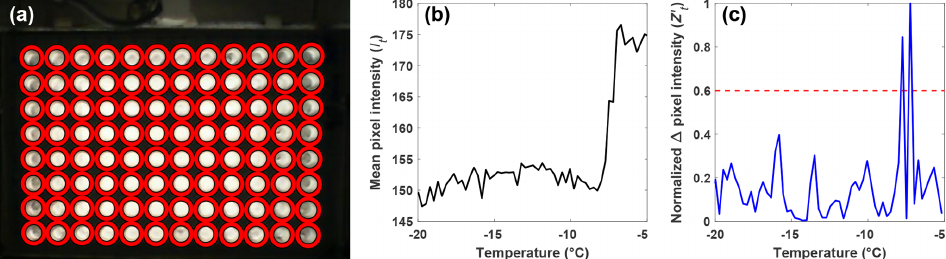
Figure 2. (a) Automatic detection of the wells (red circles) using a CHT. (b) Light intensity, or I t , of a single well as a function of temperature as observed by the webcam, and (c) the normalized change in pixel intensity, Z (cid:48) t , for the same well as in (b) between subsequent pictures taken during an experiment, as a function of temperature. The most intense peak corresponds to the ice nucleation temperature, and the second-most intense peak is due to the slow freezing of the solution after nucleation. The red dashed line represents the 0.6 threshold required for a well to be classified as